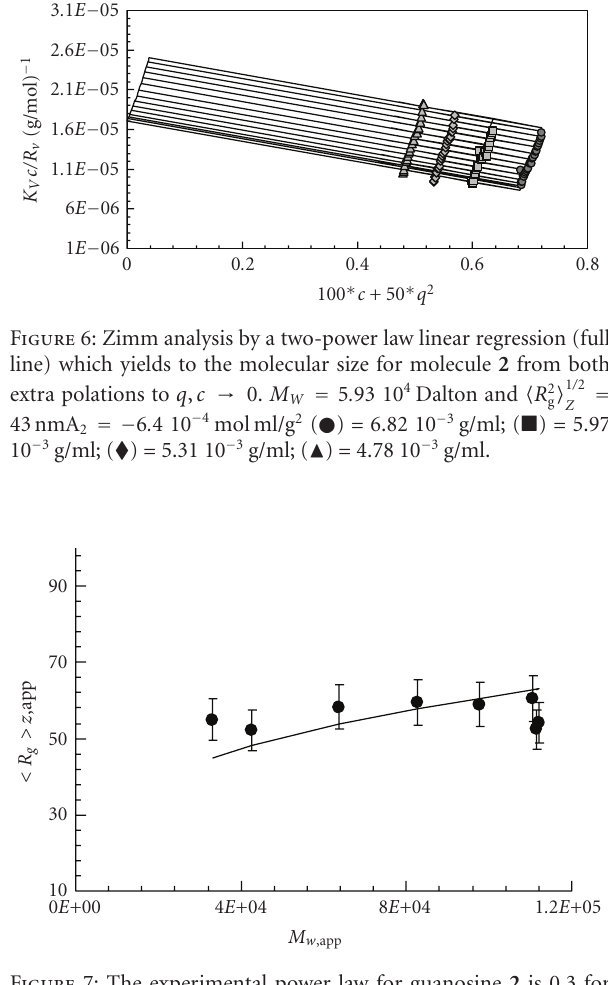
Figure 7: The experimental power law for guanosine 2 is 0.3 for the apparent Molecular weight ( (cid:3) ). The result shows a signature of very compact object and is the value for an athermal binary solution as ascertained by the low value for A 2 , the second virial coe ffi cient (error bars of 10%).